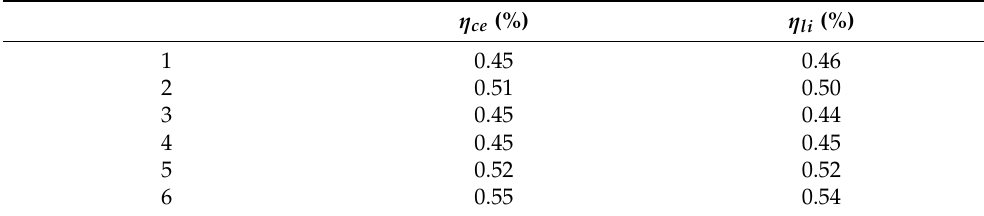
Table 5. Comparison of the values obtained by Cross-Entropy ( η ce ) with values from the literature ( η li ) in